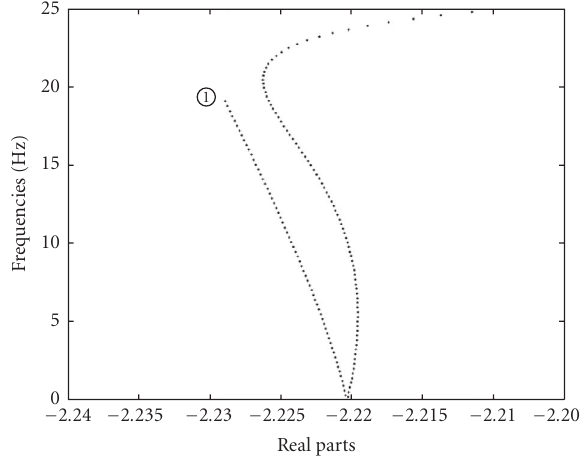
(cid:2) 1 in the complex plane